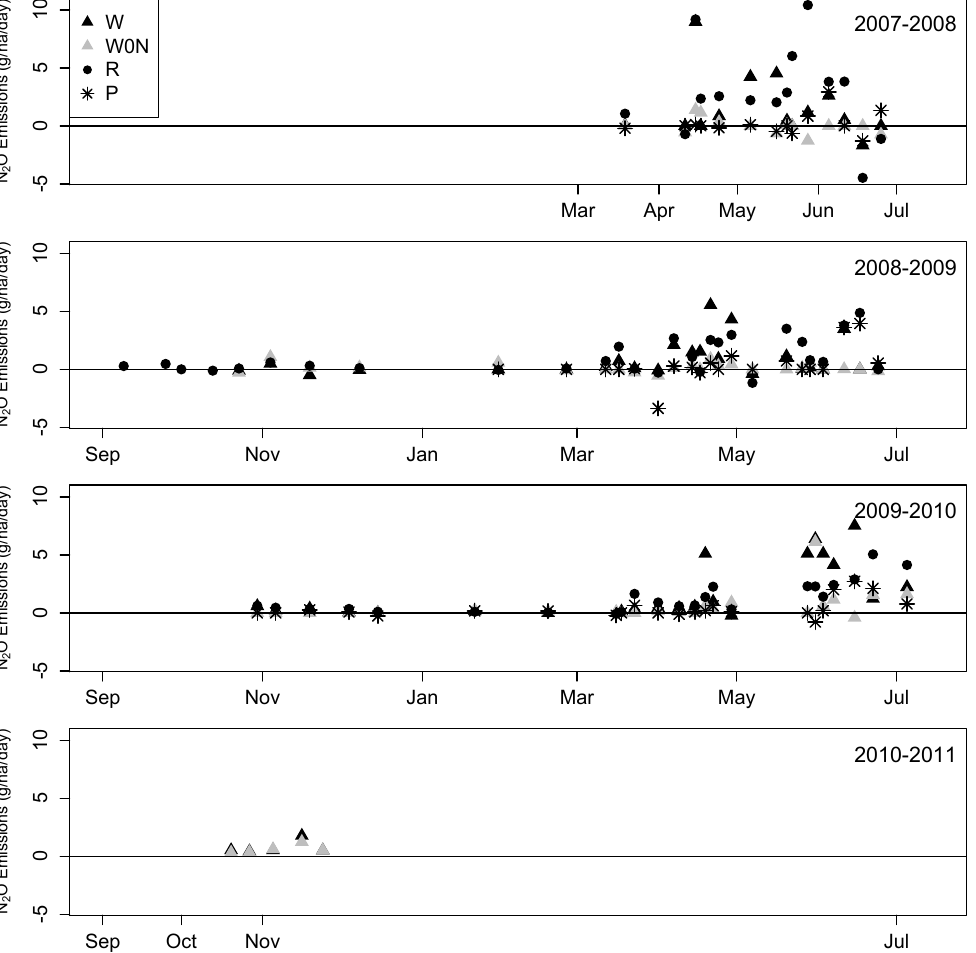
Fig. 2. Mean N 2 O fluxes (mean over all blocks and preceding crops) against date for the different crops (W=wheat, W0N=unfertilized wheat, R=rape, P=pea) for each cropping season (gN-N 2 Oha − 1 day − 1 ). Dates of fertilization have not been included in the figure as they vary according to the crop and preceding crop